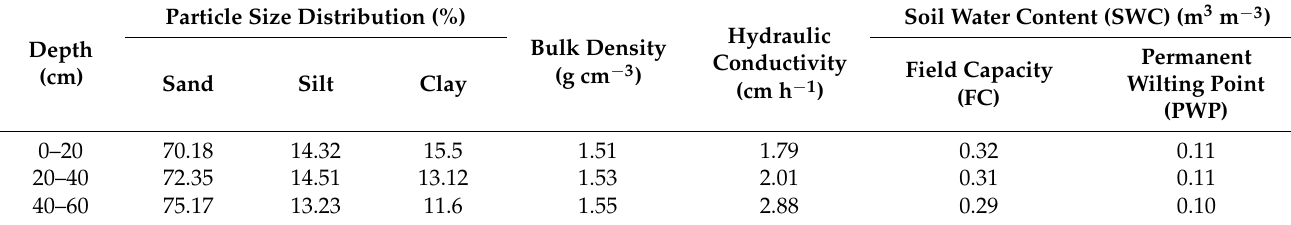
Table 2. Soil physical properties of the experimental